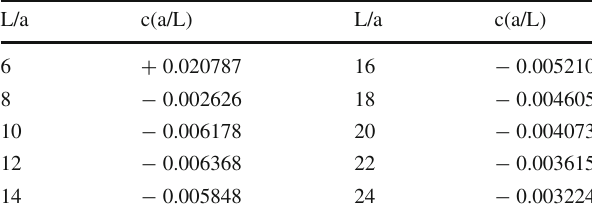
P in the SF scheme